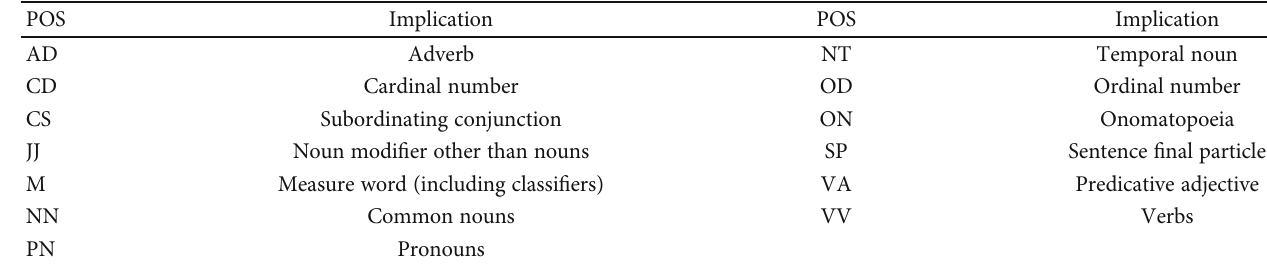
Table 8: POS from Penn